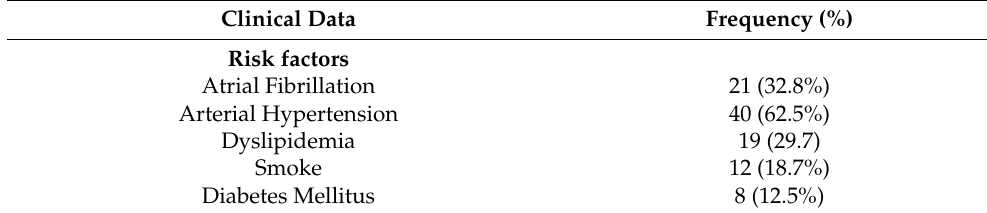
Table 1. Clinical and demographic data of the enrolled